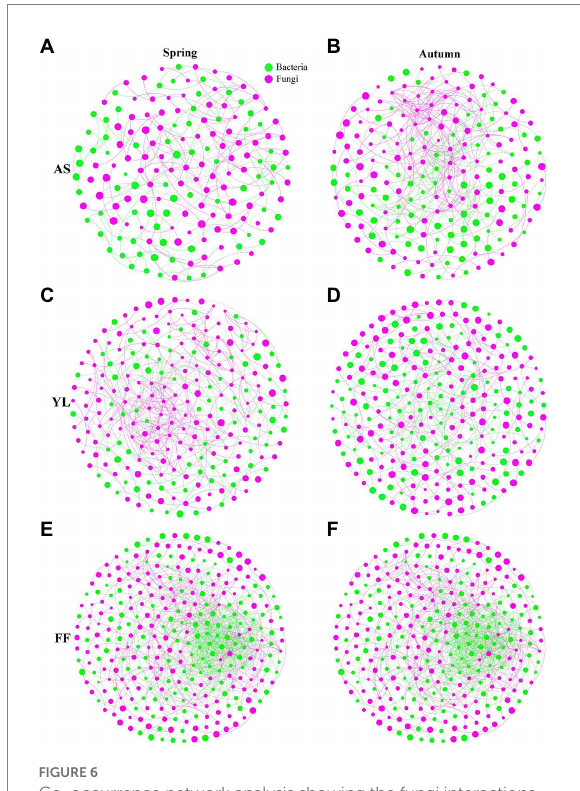
FIGURE 6 Co-occurrence network analysis showing the fungi interactions with bacteria among AS, YL, and FF phyllosphere in spring and autumn (A–F)